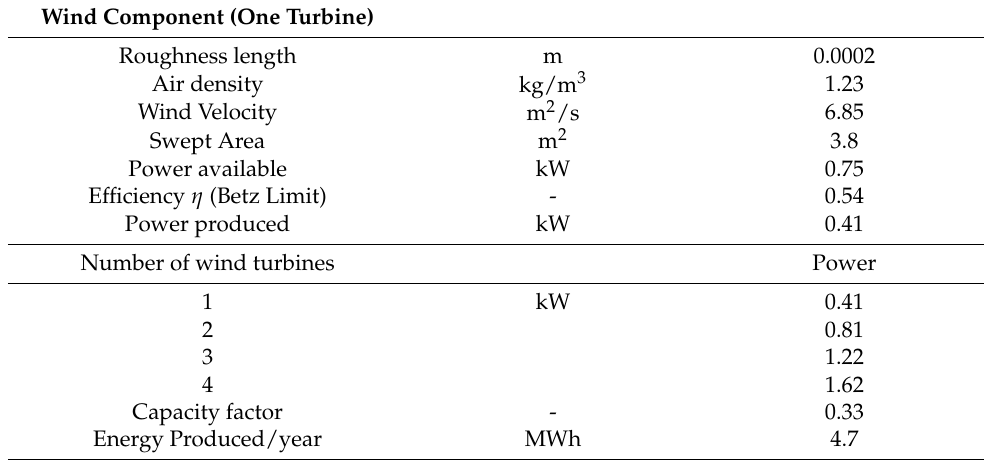
Table 7. Vertical axis wind turbine (VAWT)